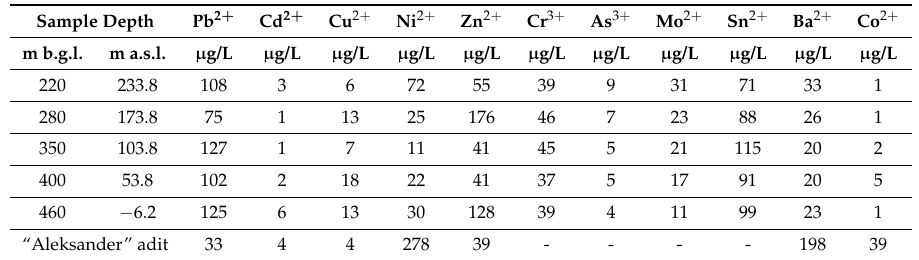
Table 2. Physicochemical analyses of water samples from the flooded “Nowy I” shaft—minor constituents. Sample